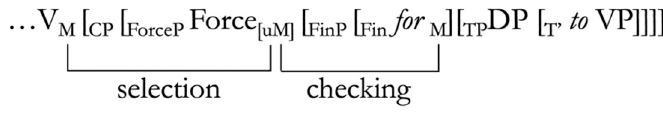
Figure 2. The syntactic structure of for–to infinitival phrases in English.